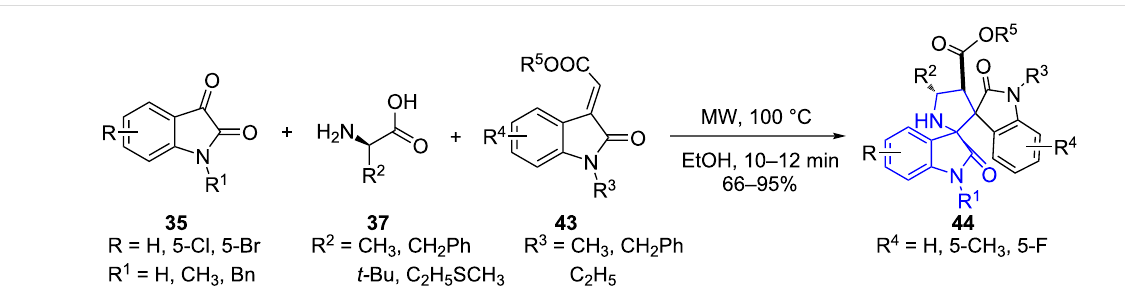
Scheme 14: Plausible mechanism for the synthesis of substituted spirooxindoles.